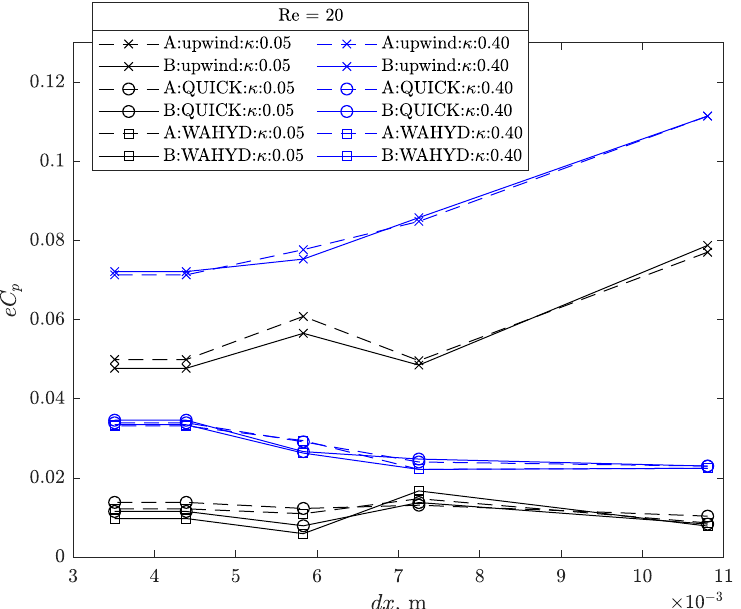
Figure 28. Pressure coefficient error as function of grid size for the flow around a cylinder case with Re = 20.